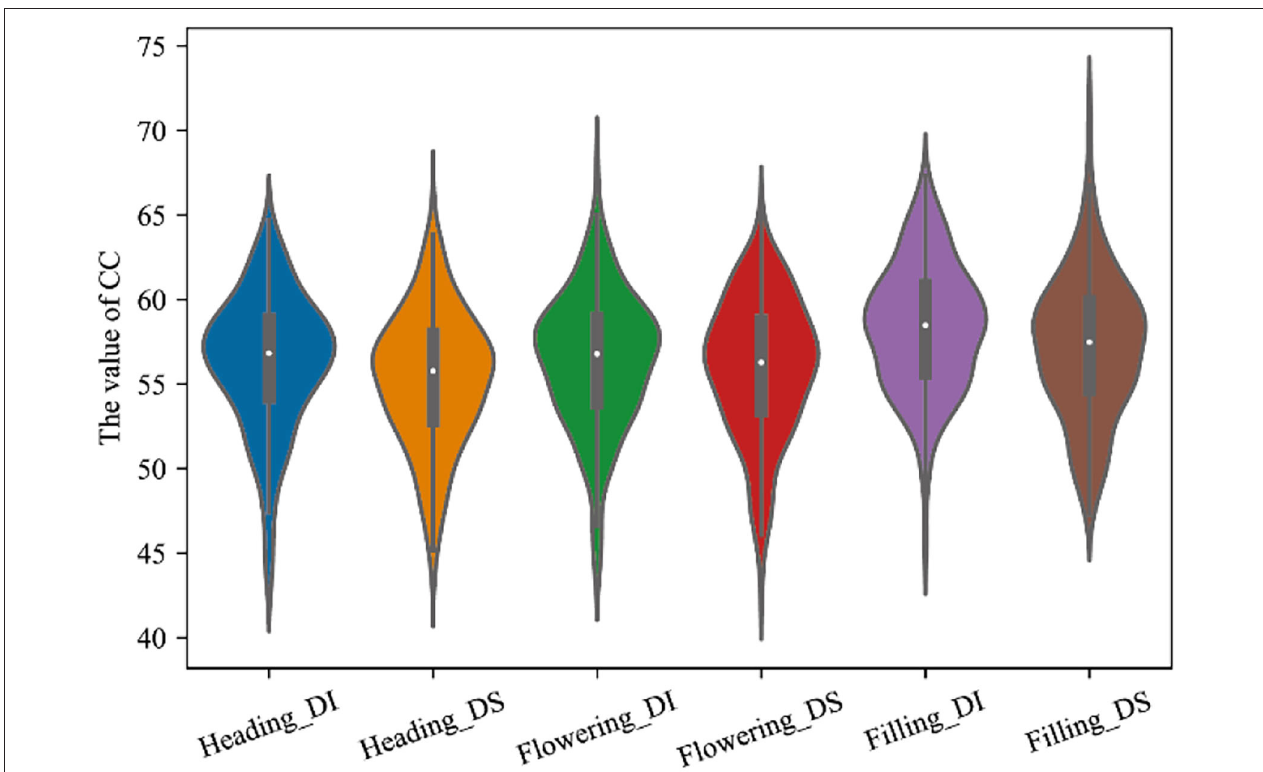
FIGURE 9 | CC distribution of winter wheat at different fertility stages under two water treatments. Heading_DI, Heading_DS, Flowering_DI, Flowering_DS, Filling_DI, and Filling_DS refer to normal treatment at heading stage, water treatment at heading stage, normal treatment at flowering stage, water treatment at flowering stage, normal treatment at filling stage, and water treatment at filling stage,